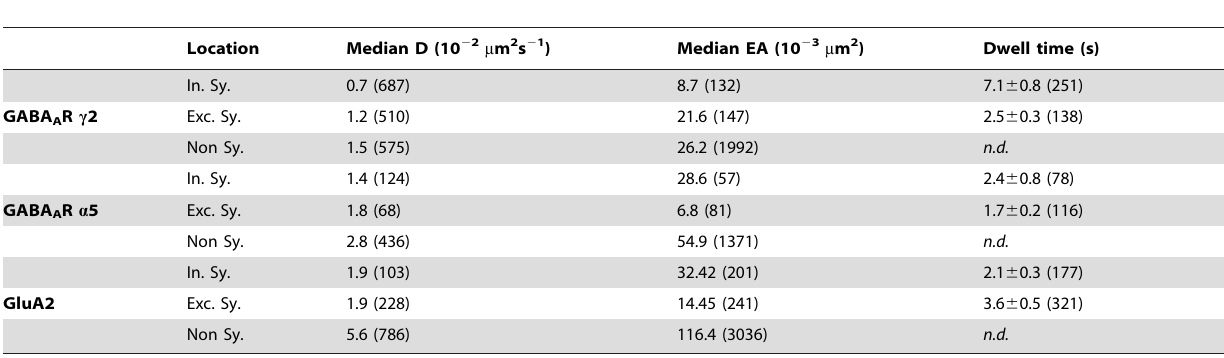
Table 1. Diffusion properties of GABAAR c 2 and a 5 subunits, and of AMPAR GluA2 subunit in relation with excitatory and inhibitory synapses.